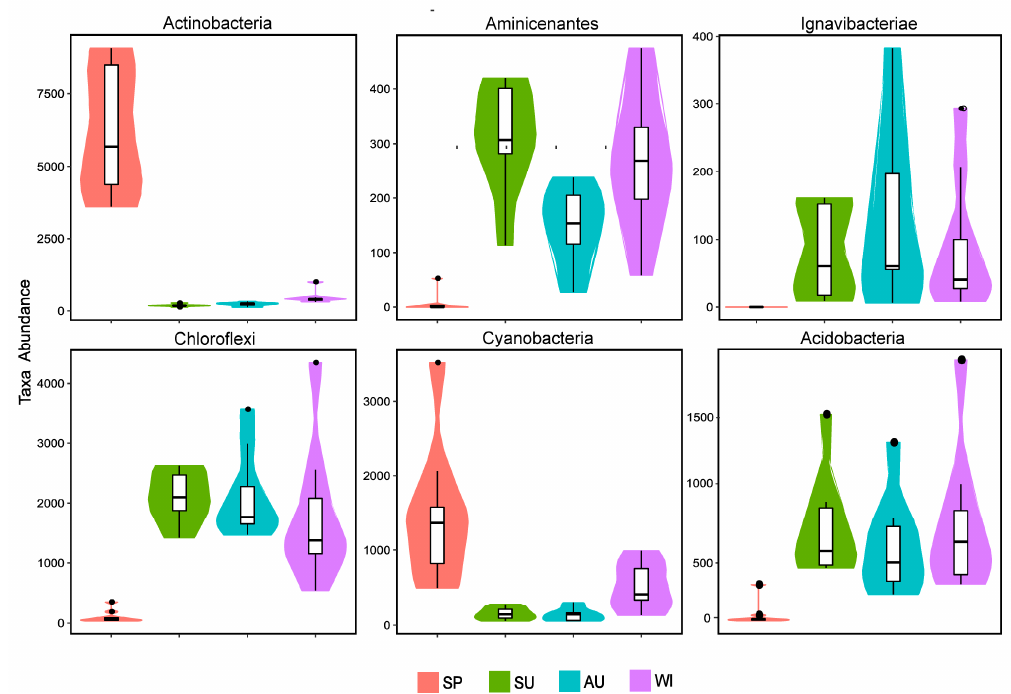
Figure 4. Abundance distributions of the six microbial populations with the most significant di ff erences in the four